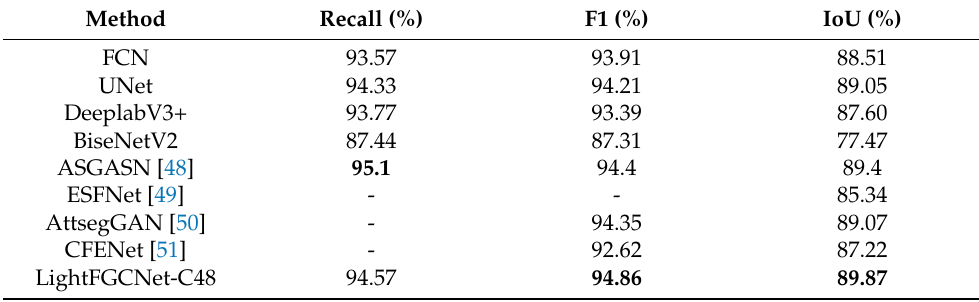
Table 8. Recall, IoU, and F1 on the WHU Building dataset. The bold indicates the best